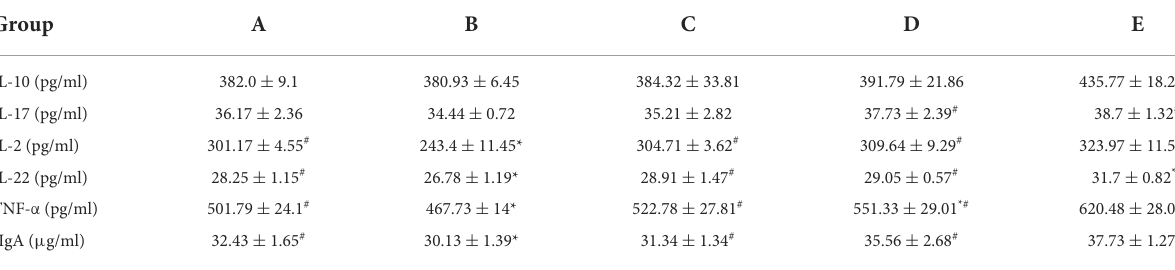
TABLE 1 Effects of CSPCM on the levels of cytokines in small intestinal tissue. Group A B C D